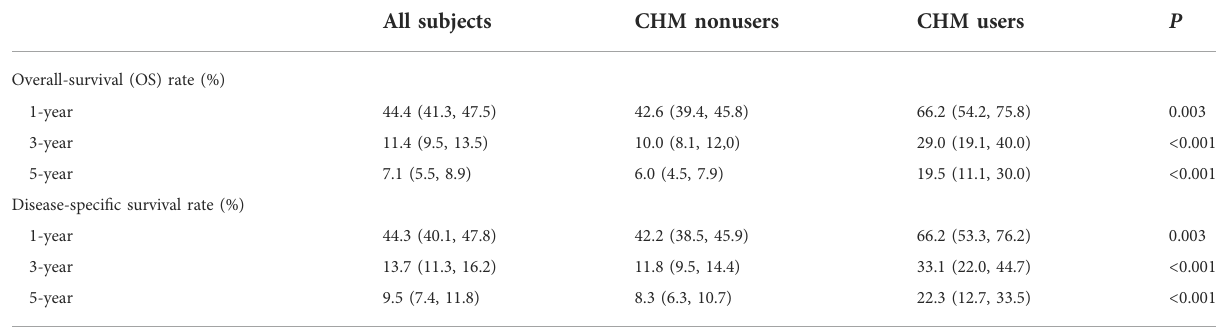
TABLE 2 The outcome of enrolled stage IV esophageal cancer patients.